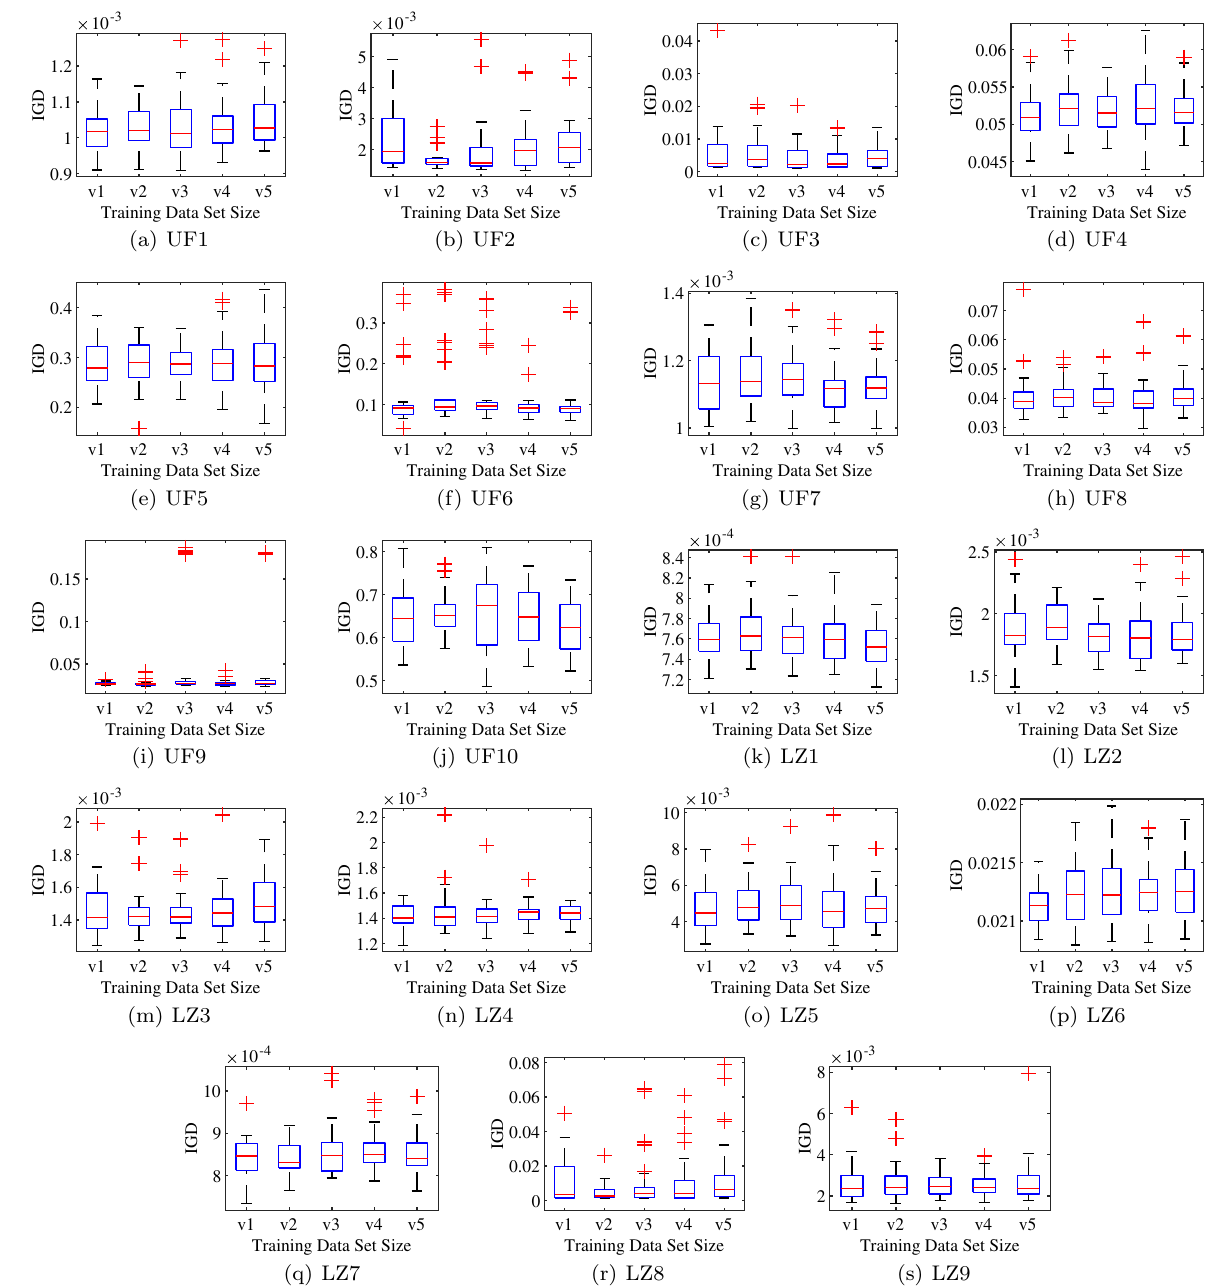
Fig. 9 Boxplots of MOEA/D-CTAOS on UF and LZ benchmarks with different training data set size. The five versions of MOEA/D-CTAOS, namely v1, v2, v3, v4 and v5, denote T S = 1000 , 2000 , 3000 , 4000 and 5000 respectively